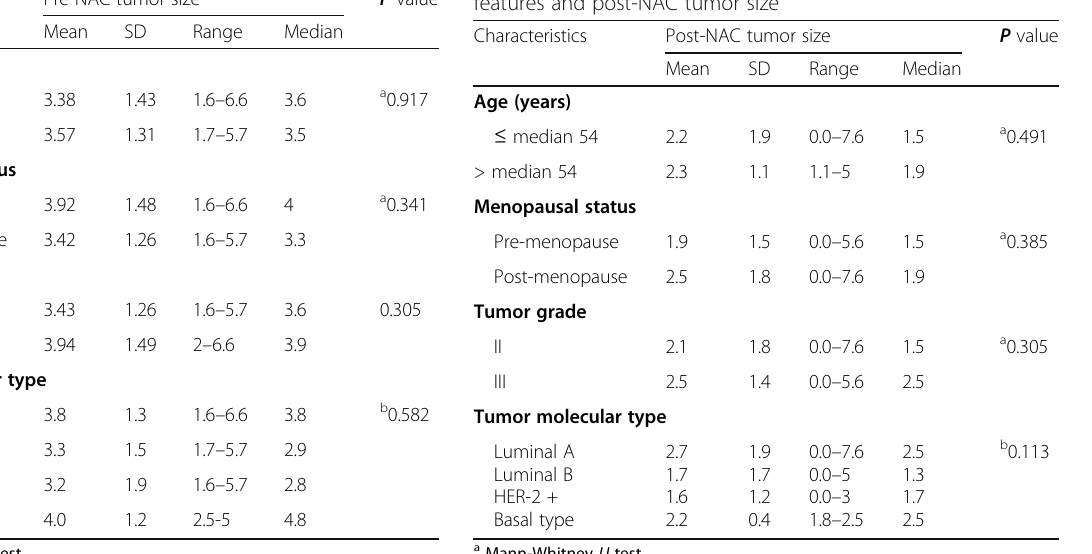
Table 4 Relationship between demographic/histopathologic features and pre-NAC tumor size Characteristics